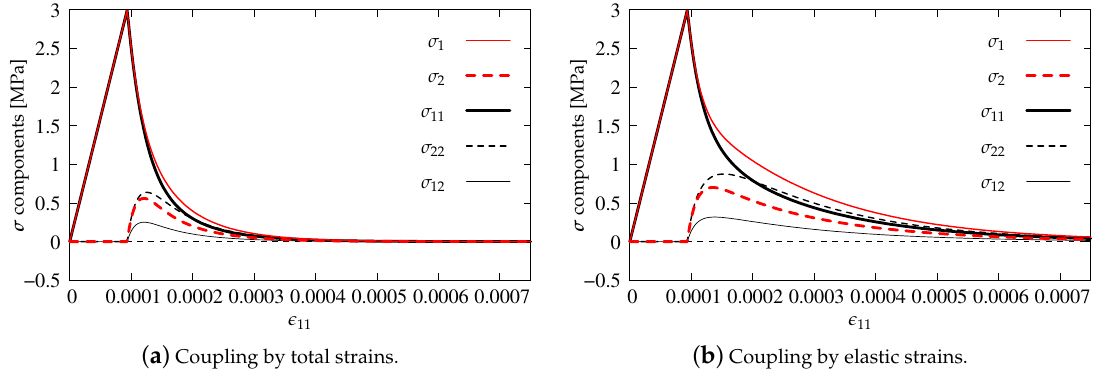
Figure 13. Comparison of stress components for DAP model—damage coupled to plasticity, modified von Mises